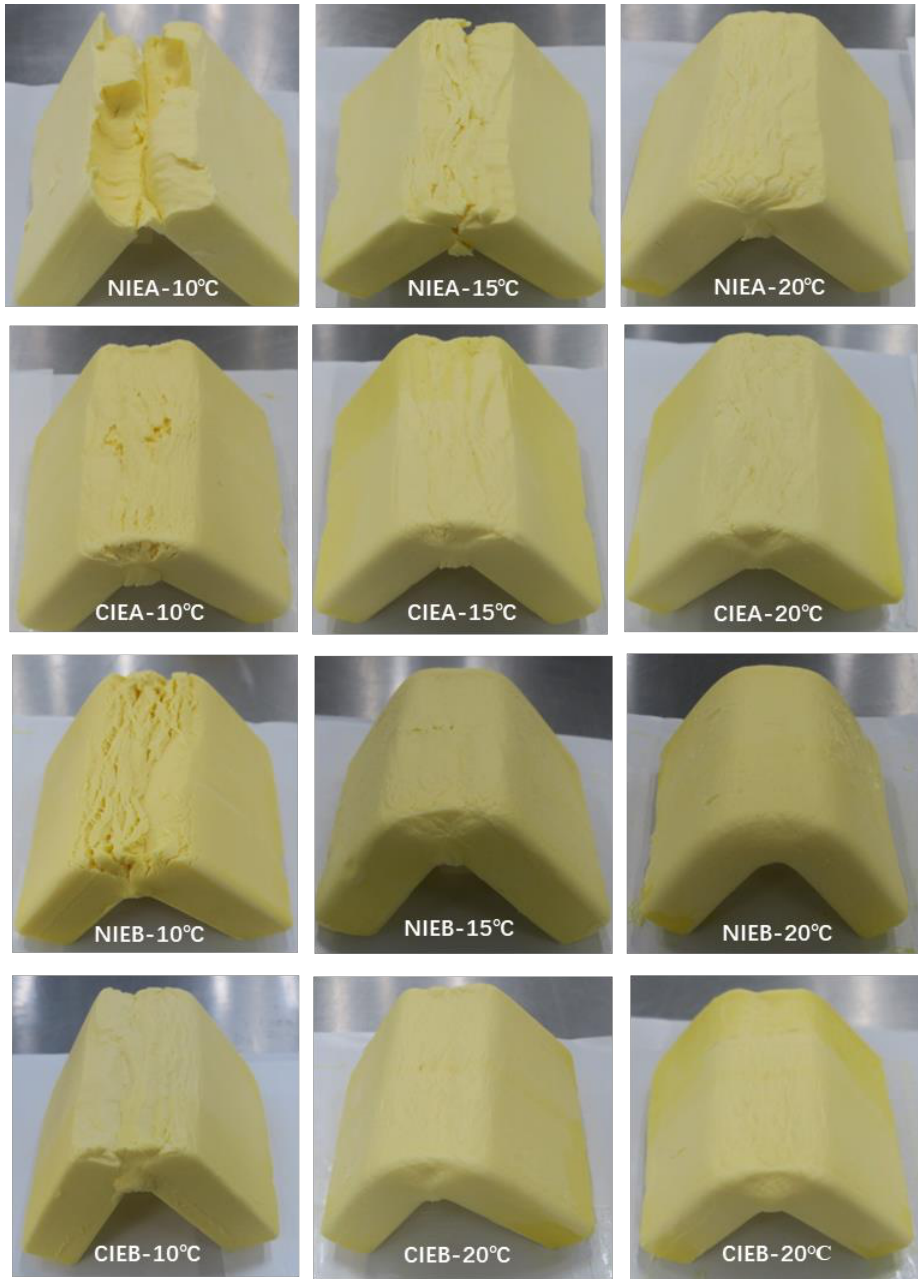
Figure 7. Bending abilities of samples at 10 °C, 15 °C, and 20 °C.